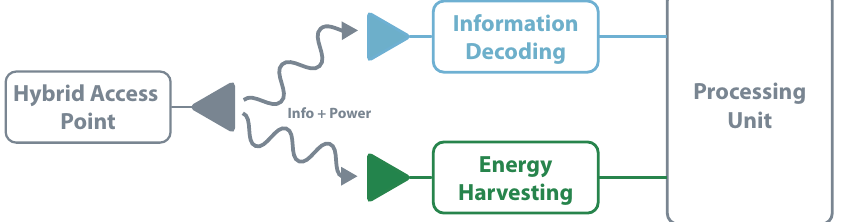
Figure 13. SWIPT—independent receiver